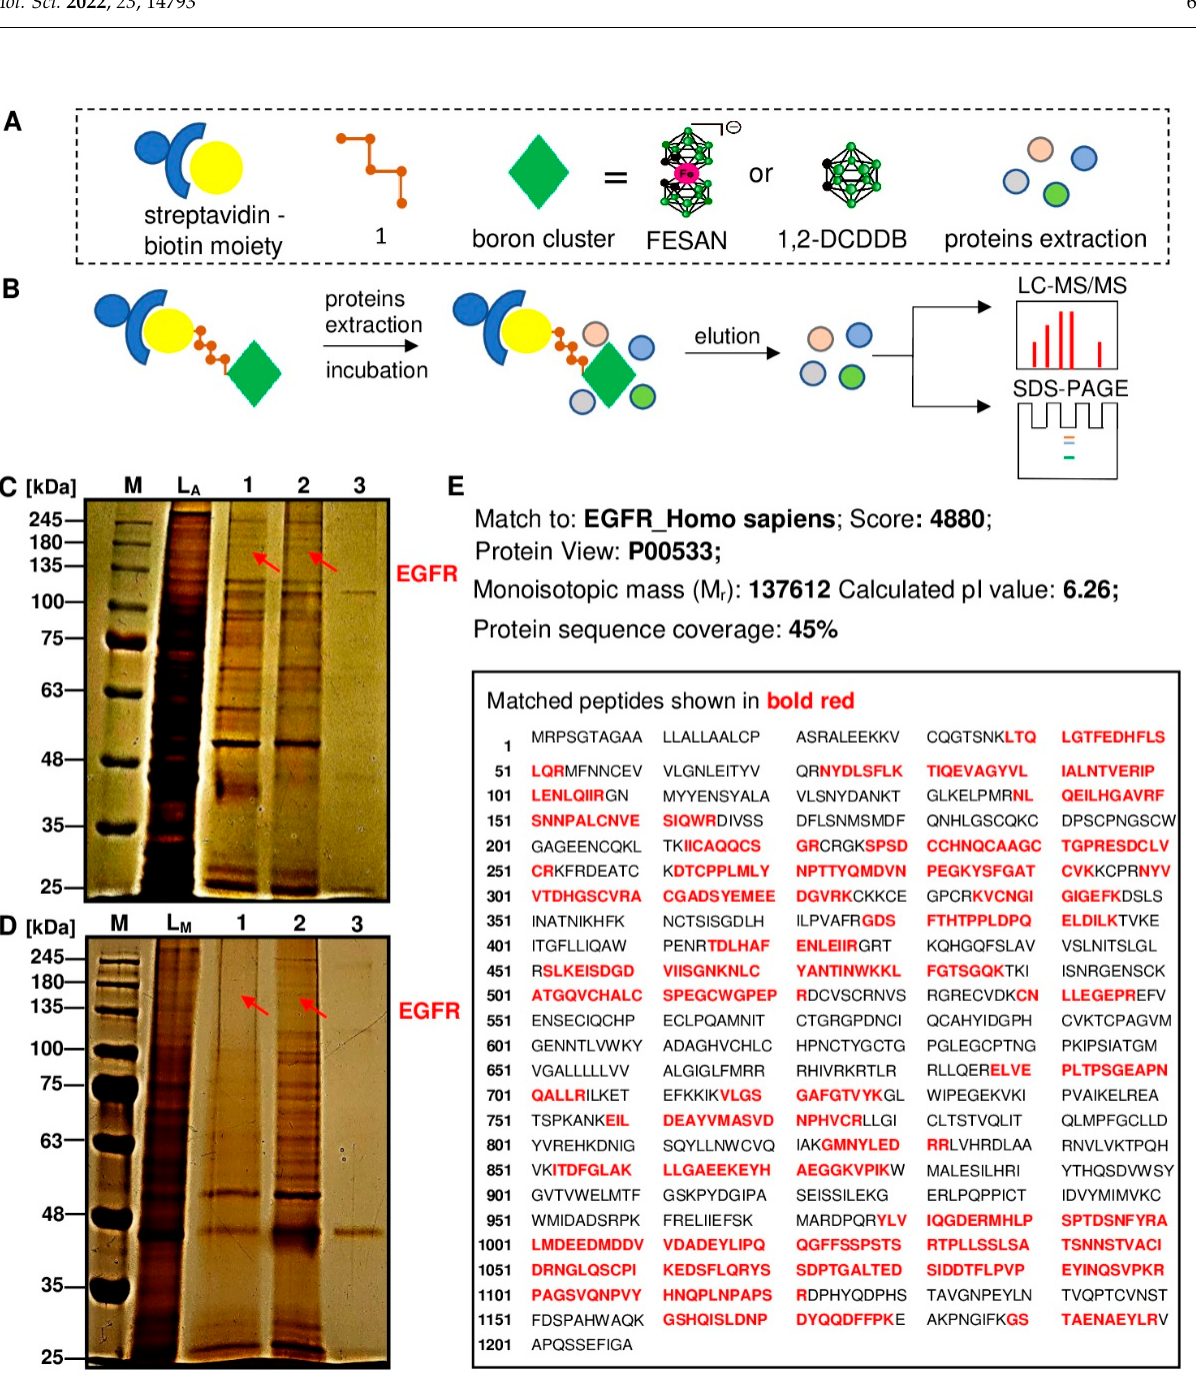
Figure 2. Schematic representation of the model ASO with fishing rod (BIOT-1) with boron cluster bait (U B1 (FESAN) or U B2 (1,2-DCDDB)) which was used to isolate cellular proteins with specific affinity ( A , B ). SDS-PAGE analysis of proteins eluted with BIOT-1-FESAN ( C , D ; lane 1), BIOT-1-1,2-DCDDB (lane 2), and BIOT-1 (control) (lane 3). Total protein mixture of epidermoid squamous cell carcinoma A431 ( C ; lane L A ) and mouse embryonic fibroblast MEF-WT cells ( D ; lane L M ). Size marker, silver staining of eluted proteins resolved to SDS-PAGE ( C , D ; lane M). Proteomic analysis of EGFR-band protein sequence by LC-MS/MS analysis. Identified amino-acid chains (bold red) match EGFR_Homo Sapiens from Mascot (version 1.9) proteomic analysis ( E ).